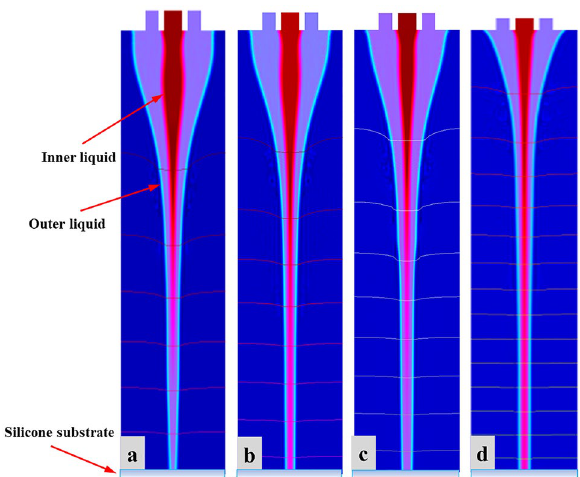
Figure 6. The specific morphologies of the simulated CE-Jet at different applied dc voltages ( a ) 5.5 kV ( b ) 6.0 kV ( c ) 6.5 kV and ( d ) 7.0